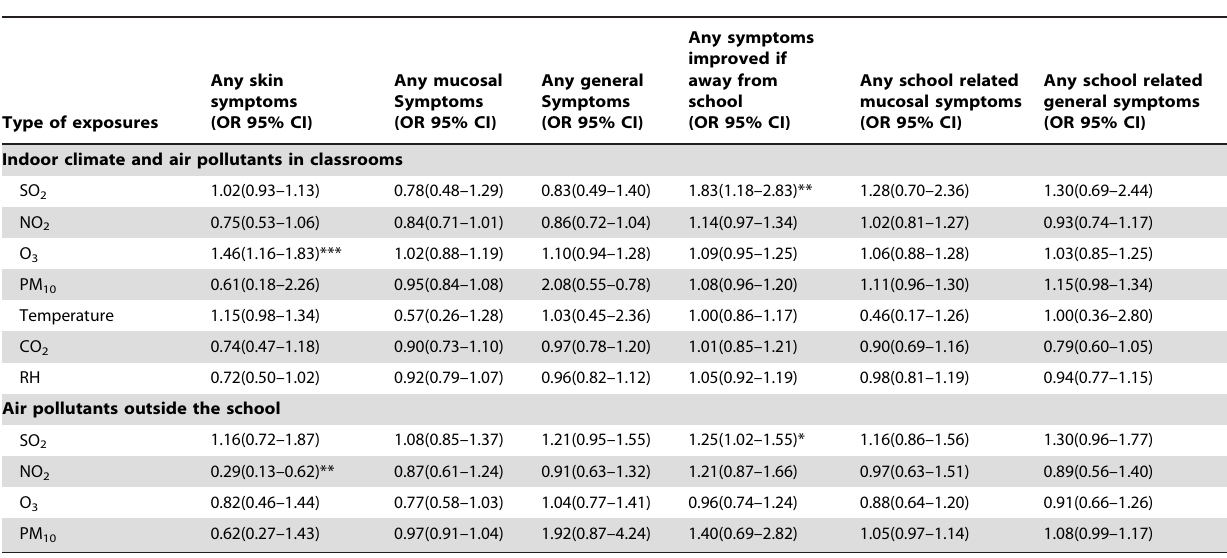
Table 7. Associations between measured environmental factors and the prevalence of weekly symptoms at baseline in 2010 (N=